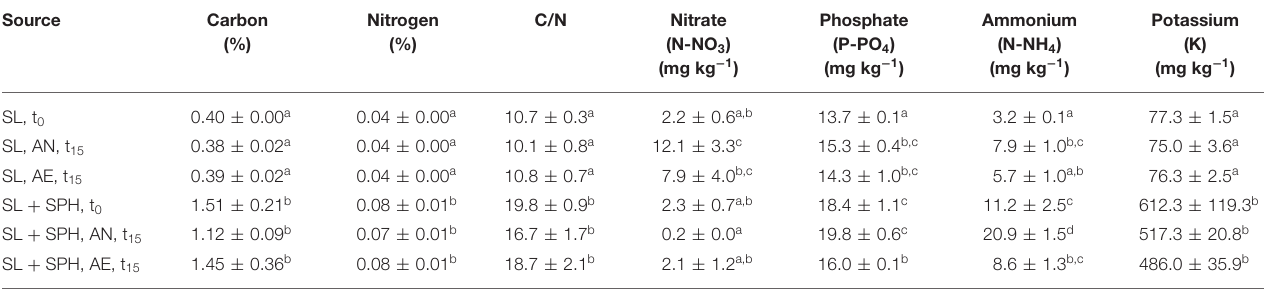
TABLE 1 | Carbon, nitrogen, C/N ratio, nitrate, phosphate, ammonium, and potassium concentrations ( n = 3) in sandy loam (SL) after 15 days (t 15 ) under different conditions (AN, anaerobic; AE, aerobic), with and without spent pollinator hulls (SPH) and at initial time (t 0